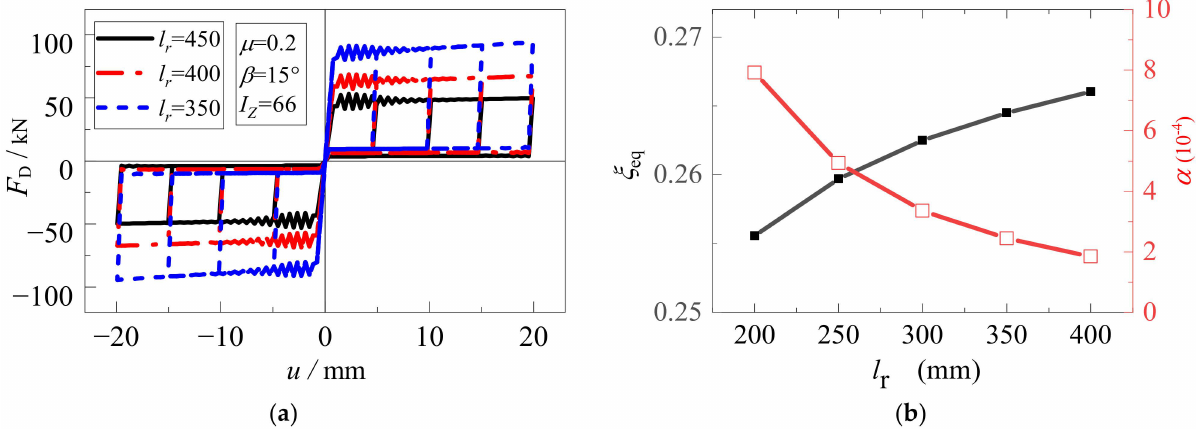
Figure 9. Effects of l r on BPSCFD: ( a ) Force-displacement relationship; ( b ) ξ eq and α . According to Equation (2), I Z plays an important role in the critical pressure of the buckling-plate. The influences of I Z on the force-displacement hysteresis curve, damping and stiffness characteristics of the damper are shown in Figure 10. Figure 10a shows that the F y and F r of the damper increases with the increase in I Z . Figure 10b shows the influences of I Z on ξ eq and α . The results show that α increases obviously with the increase in I Z , while ξ eq is nearly independent on I Z